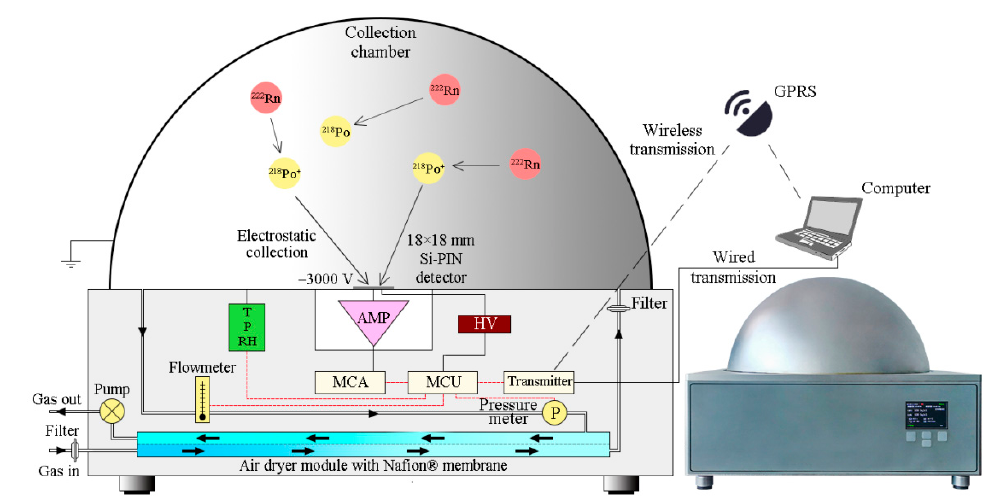
Figure 1. Schematic diagram and photo of the upgraded radon